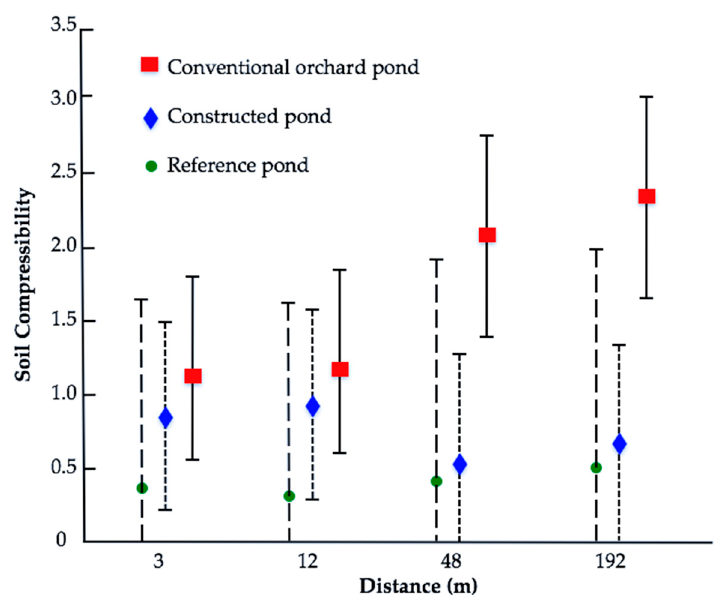
Figure 3. Soil compaction varied significantly with distance among a subsample of constructed, conventional orchards, and reference ponds with substrate compaction increasing with distance among conventional orchard and remained consistent among reference sites (Tukey: F (6, 105) = 2.24, p = 0.05). Bars denote 95% confidence interval.